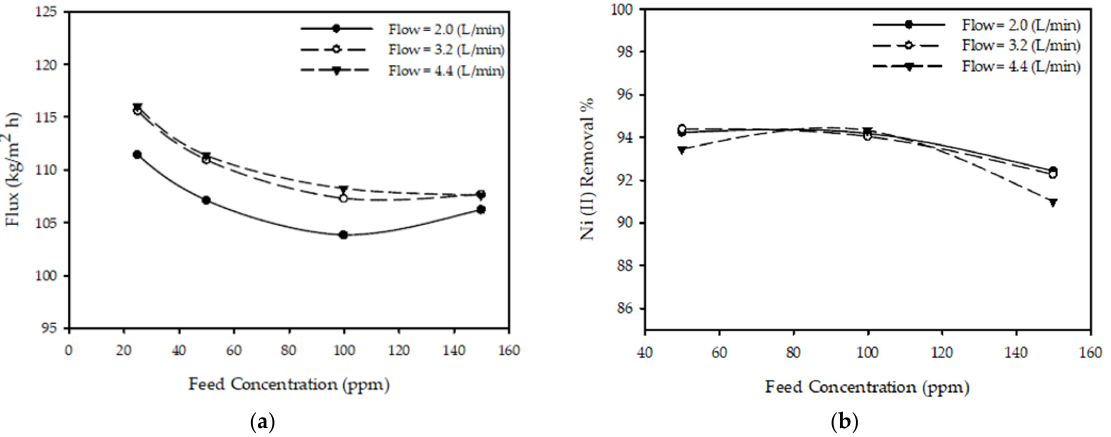
Figure 4. Feed concentration impact on ( a ) permeate flux and ( b ) Ni (II) removal % for feed flow rates with a constant pressure of 20 bar and a temperature of 45 °C.